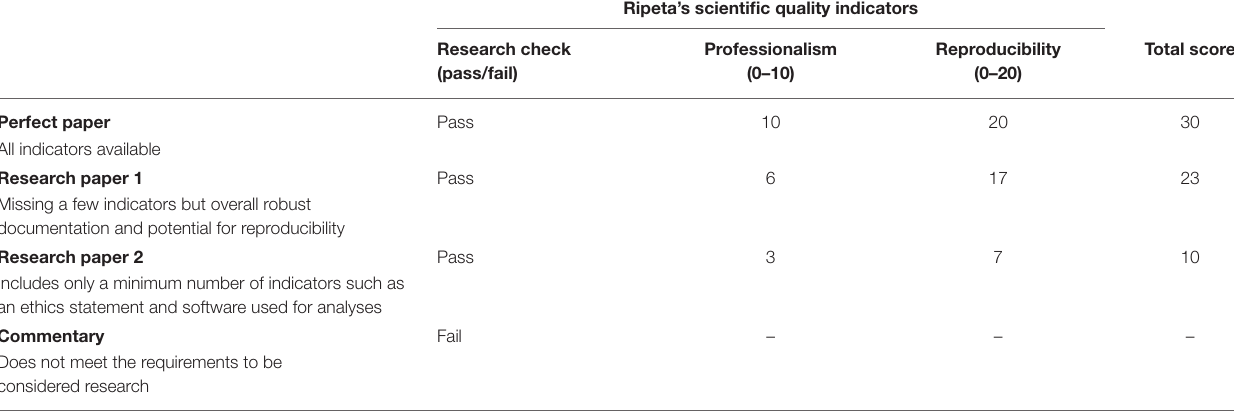
TABLE 1 | RipetaScore breakdown across scientific quality